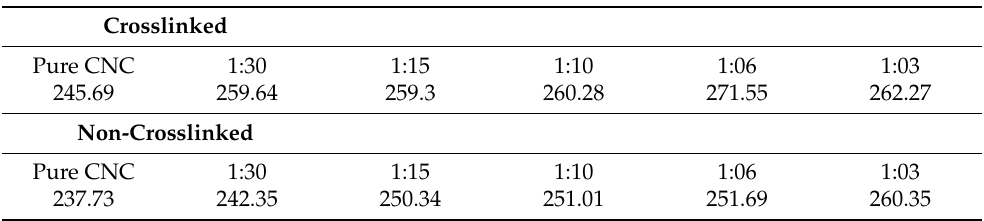
Figure 12. TGA curves of CNC and CNC/CZ films. ( a ) Non-cross linked films ( b ) cross linked films. Table 2. Temperature at maximum rate of mass loss in the first degradation step for crosslinked and non-crosslinked films.